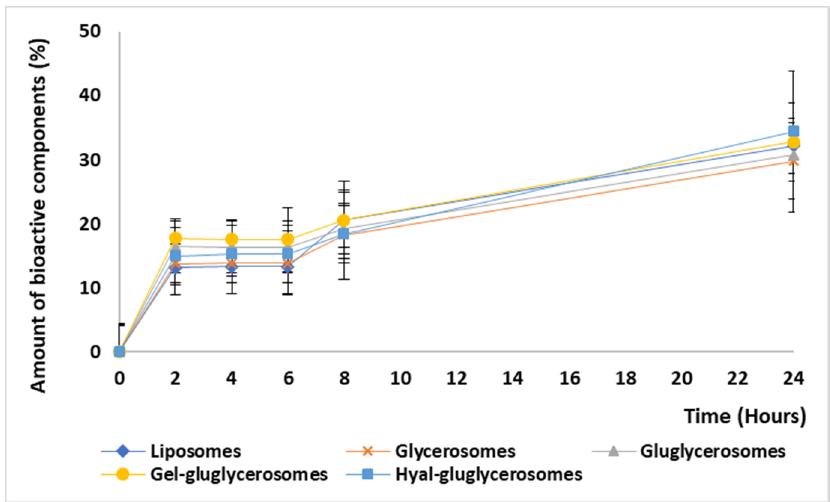
Figure 4. Amount of bioactive components (%) released from liposomes, glycerosomes, gluglycerosomes, gel-gluglycerosomes, and hyal-gluglycerosomes during 24 h of experiment. Mean values (error bars) ± standard deviations are reported (n = 3).